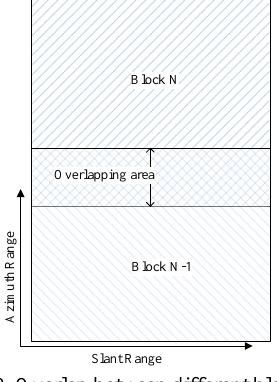
Fig.2. Overlap between different blocks All of the baseline parameters ( B and  ) and interferometric  in blocks need to be estimated to derive accurate phase offset 0 DEMs and mosaic the DEMs.